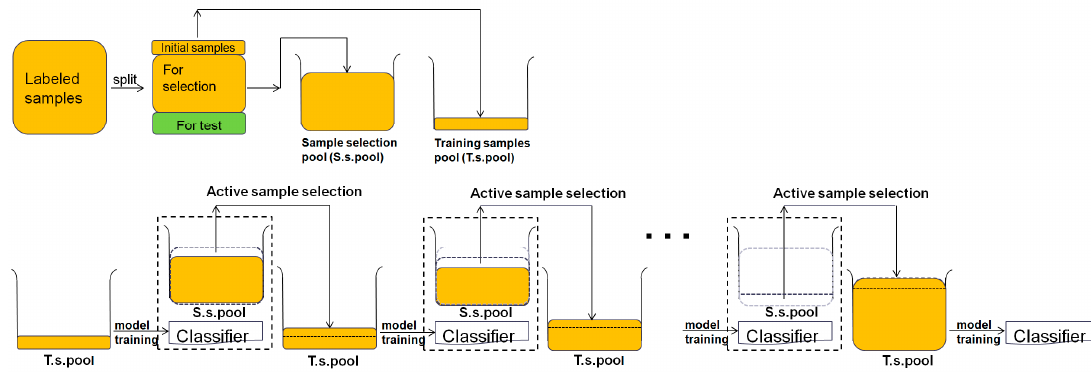
Figure 2. The scheme of exploring the potential of AL in building oil spill classification systems using ten-year RADARSAT